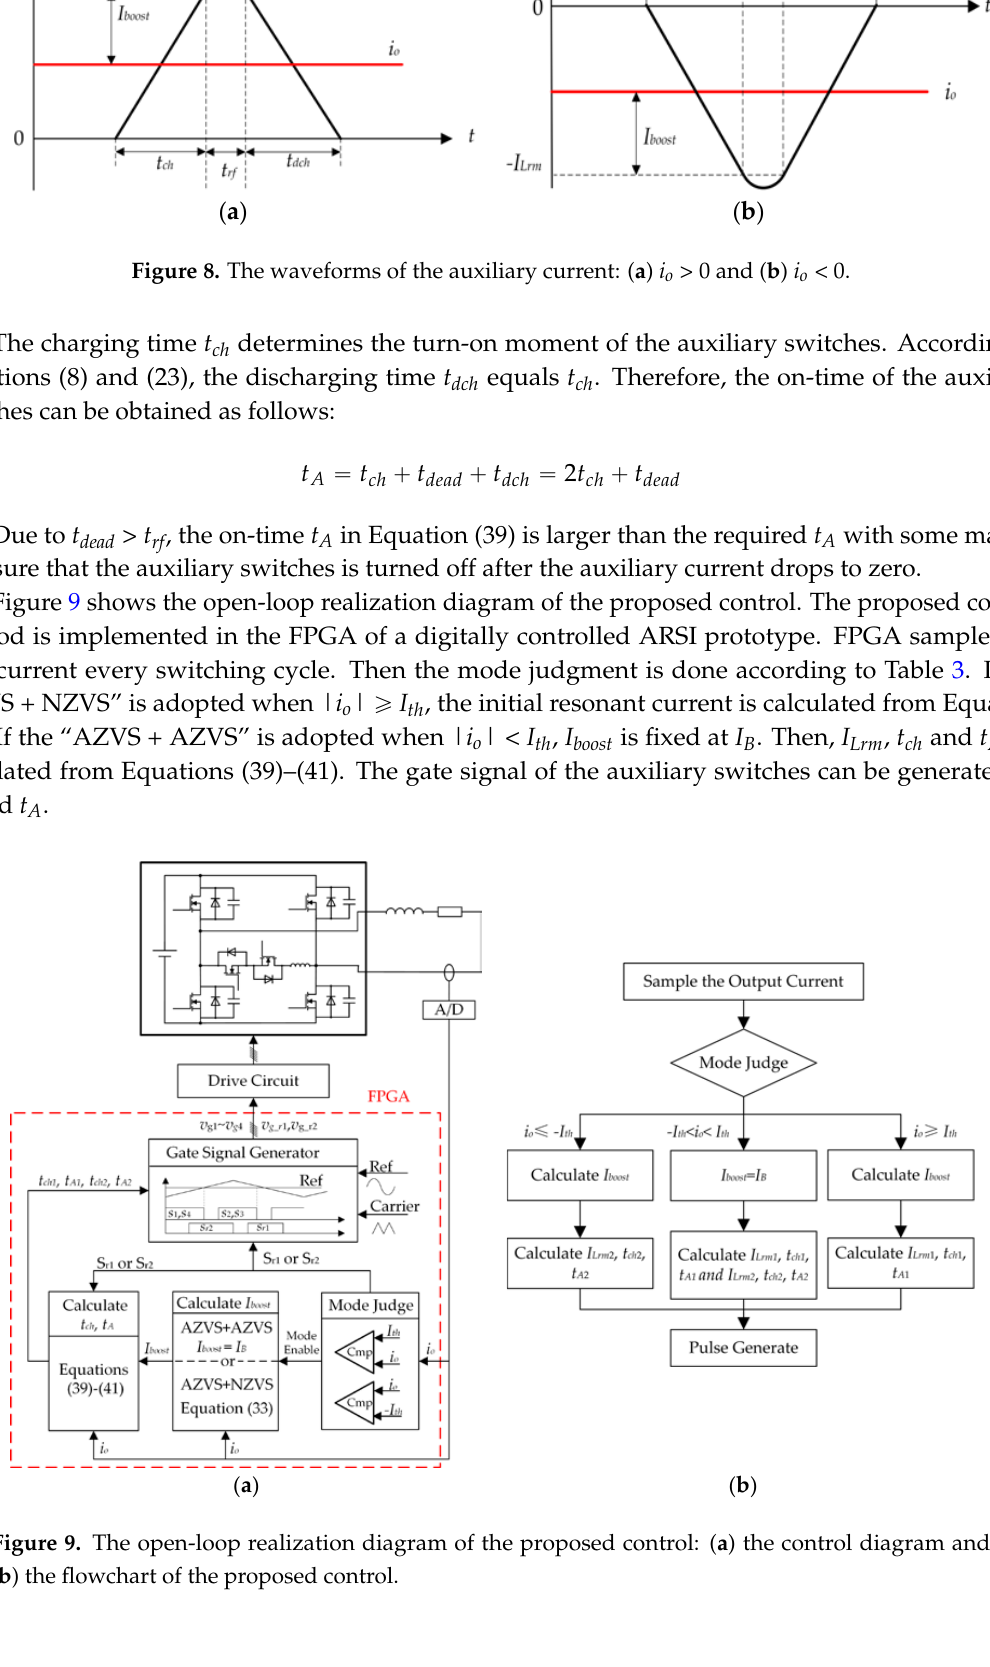
Figure 10. The photograph of the prototype. Wires for current measuring